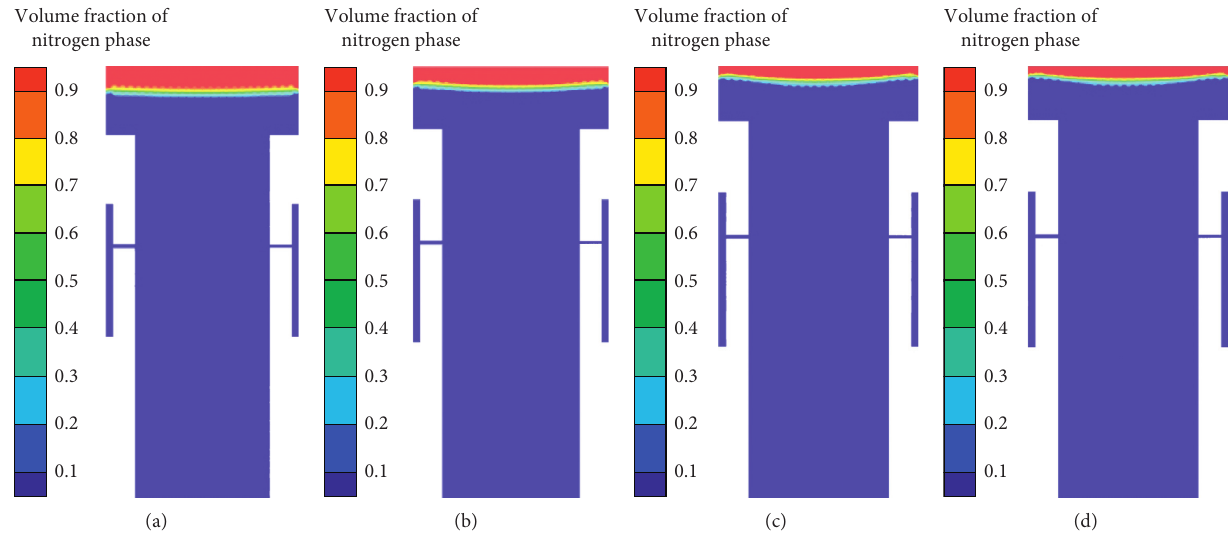
Figure 6: Volume changes of oil and nitrogen during the compression stroke at (a) t � 0.02s, (b) t � 0.04s, (c) t � 0.08s, and (d) t � 0.1s. The blue area is the hydraulic oil, the red area is the nitrogen, and the green area is the interface between the two phases.